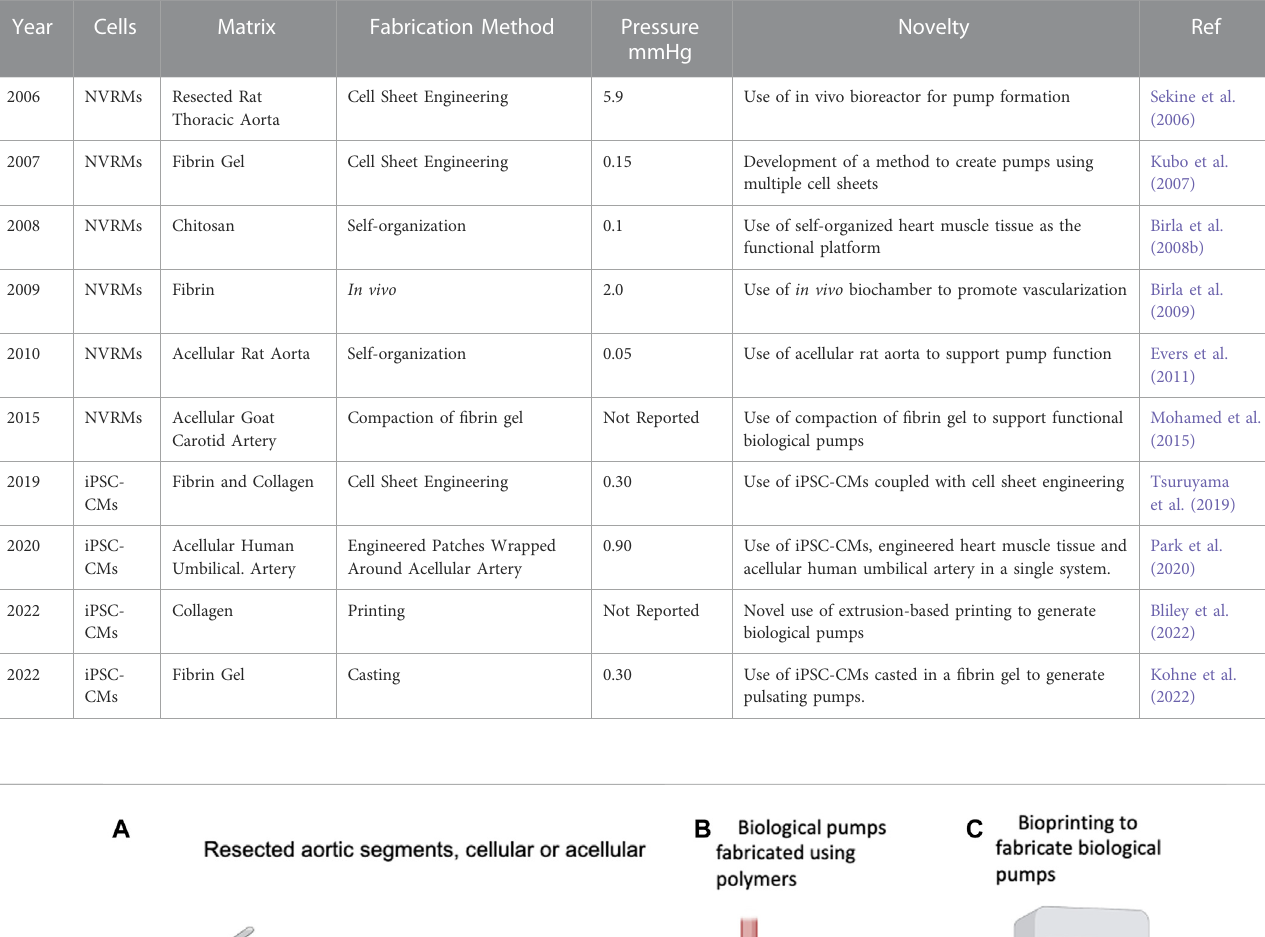
TABLE 1 Models of biological pumps.